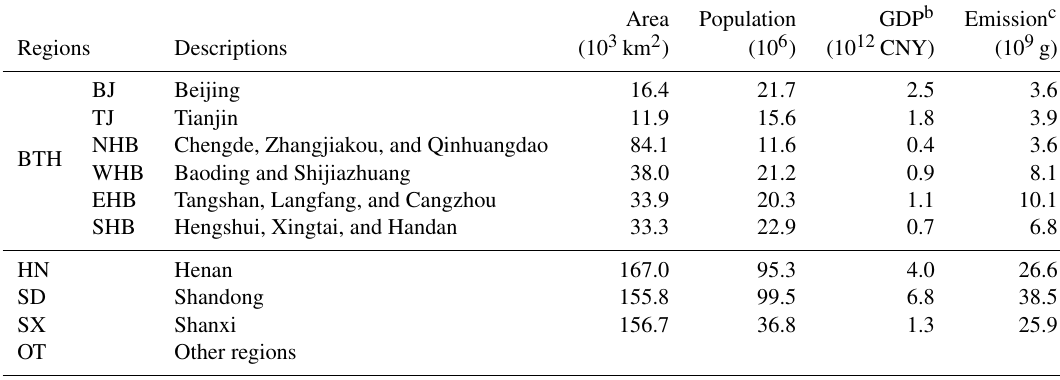
Table 1. Source-tagging regions and primary PM 2 . 5 emissions from 15 November to 15 December 2016 in this study a .